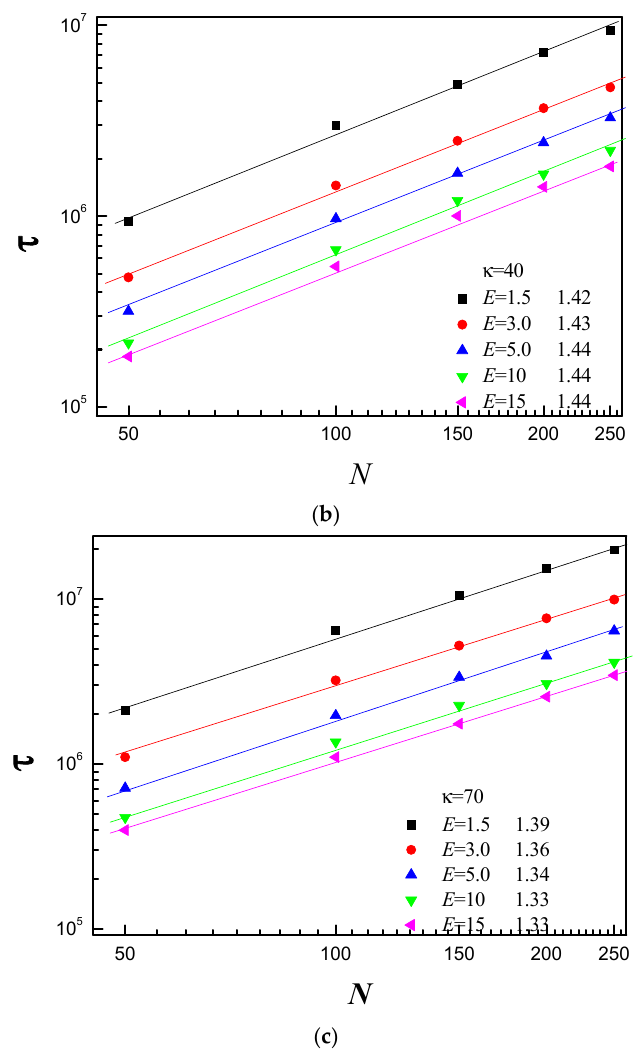
Figure 4. The average translocation time τ as a function of chain length N under the different electric field E : ( a ) for bending stiffness κ = 10; ( b ) for κ = 40; and ( c ) for κ = 70.